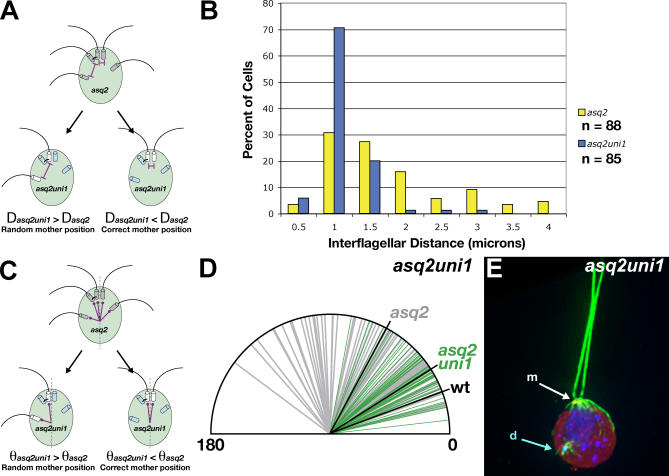
In asq2 Cells, Mother Centrioles Are Properly Localized, Whereas Daughters Are Not(A) If mother centrioles (white) are properly positioned, then the distance between flagellated centrioles in asq2uni1 mutant cells should be much smaller and less variable than that of single-mutant cells.(B) The distance between flagellated centrioles in biflagellate asq2uni1 cells is much smaller and less variable (mean = 0.89 ± 0.36 μm, n = 85) than in biflagellate asq2 cells (mean = 1.48 ± 0.85 μm, n =88). This difference is highly significant (one-tailed t-test, p < 1.23 e−8)(C) If mother centrioles (white) are properly localized, then the θcentriole should be much smaller and less variable for flagellated centrioles in asq2uni1 cells than for asq2 cells.(D) θcentriole for flagellated centrioles in asq2uni1 cells is significantly (one-tailed t-test p < 2.02 e−10) smaller (green lines, mean θcentriole = 32.4 ± 13.1°, n = 60) and less variable than in asq2 cells (grey lines, mean θcentriole = 61.7 ± 32.4°, n = 71).(E) Flagellated mother centrioles (m; white arrow) are properly localized in asq2uni1 cells, whereas unflagellated daughter centrioles (d; blue arrow) are not. Cells are labeled with anti-acetylated tubulin and centrin antibody (green), anti-Bld10p antibody specific for centrioles (red) and DAPI (blue). Misplacement of nonflagellated daughter centrioles in vfl2uni1 indicates that uni1 does not simply suppress the centriole positioning phenotype of vfl2.